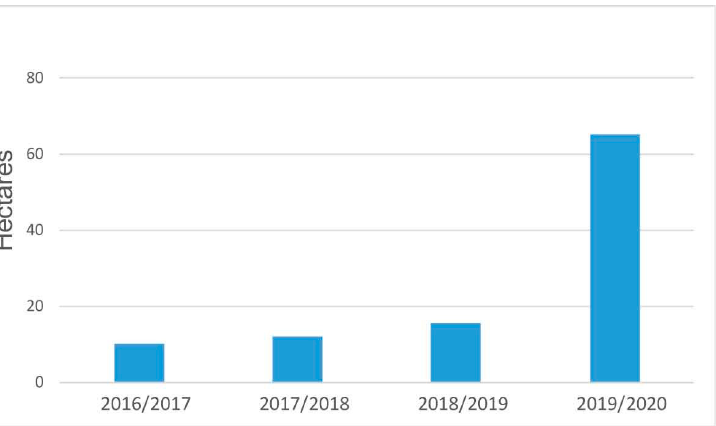
Figure 10. Growth of cultivated areas (swidden or permanent in ha) for two successive years since